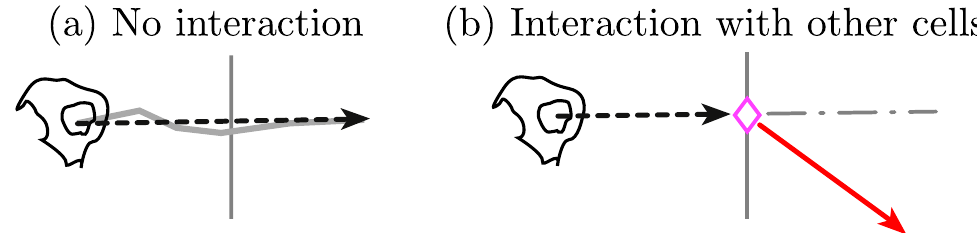
Figure 1. Illustration of the main hypothesis in this work. The interactions of the cells in a clump appear to influence on the migration patterns of the cells. The diagram shows ( a ) the case where a cell’s trajectory does not change significantly from a point chosen arbitrarily, where the grey line segments correspond to the trajectory of the cell; ( b ) shows the expectation of a cell that interacting in a clump and changing direction noticeably, the marker ( (cid:5) , magenta) represents a cell-cell contact. In ( b ), dotted arrows represent the direction of the cell, before (black) and after (red)